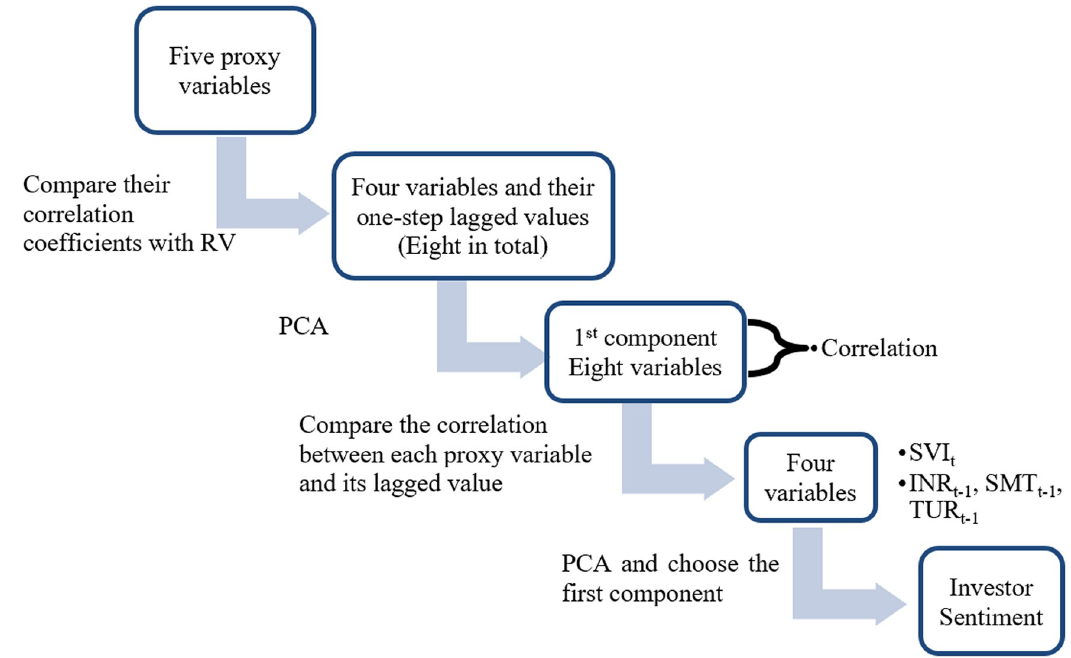
Fig 3. Process of constructing investor